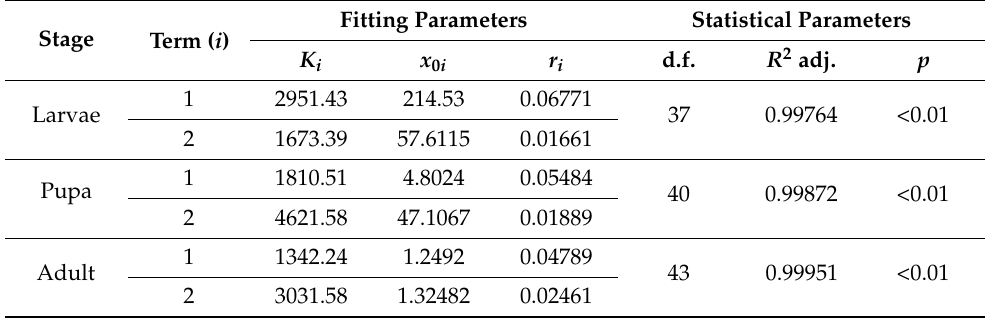
Figure 1. Fitted curve of density-time function model (3) for larvae ( a ), pupae ( b ) and adults ( c ) of Rhynchophorus ferrugineus . Table 2. Values of fitting parameters of double logistic functions for pest populations of